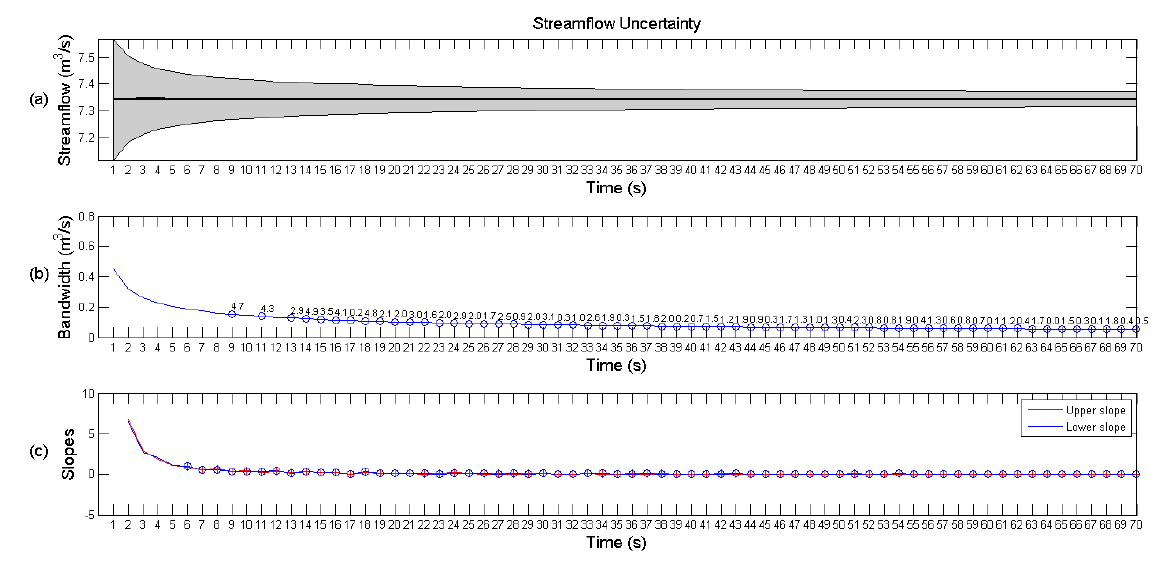
Table 2. Percent difference of uncertainty bandwidth for different times.